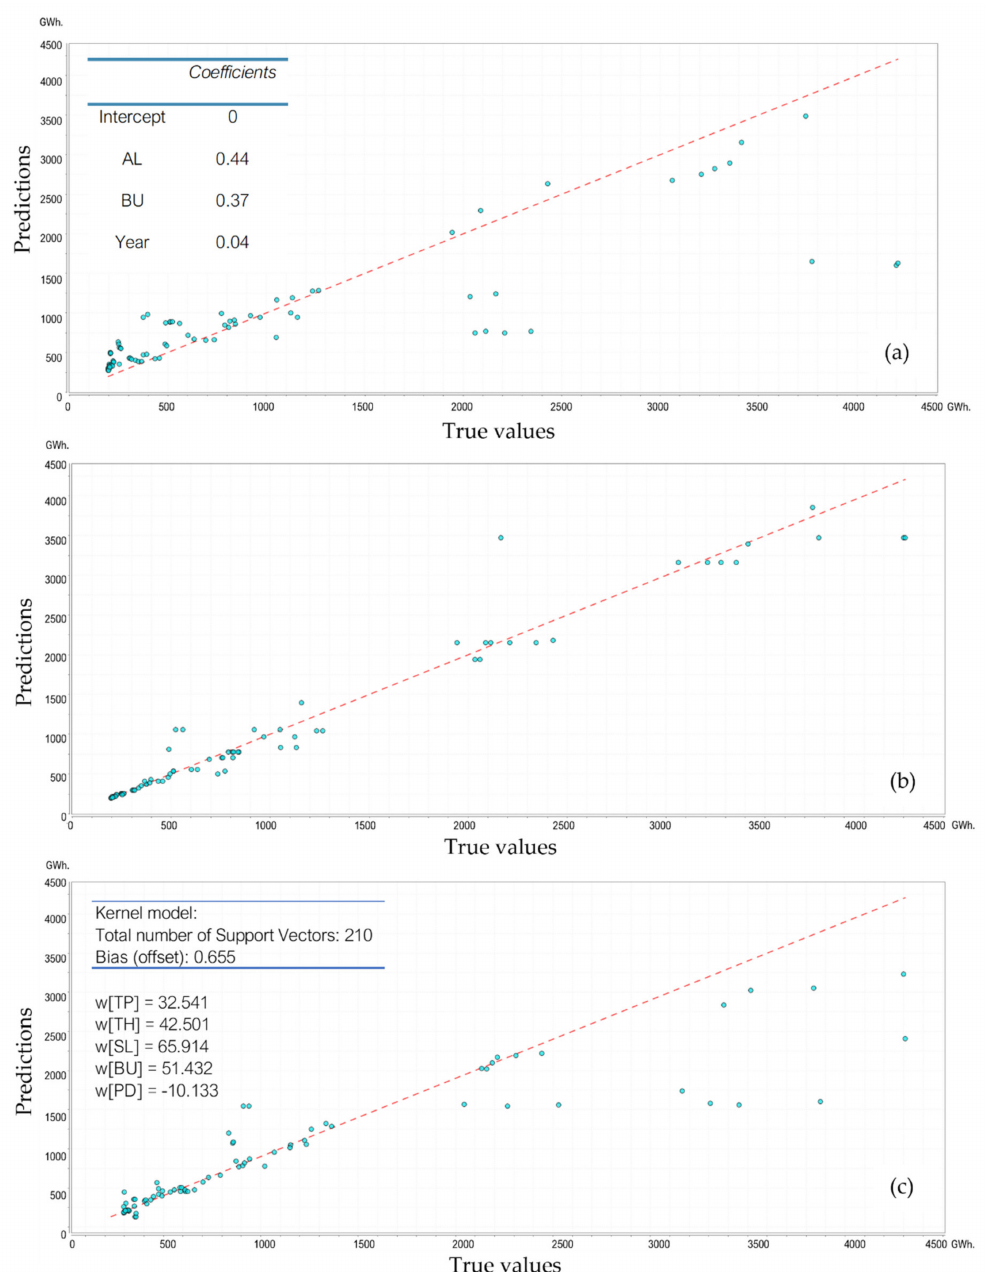
Figure 5. The scatter plots of predicted values versus actual values from different models, including ( a ) Multiple regression, ( b ) Decision Tree, and ( c ) Support Vector